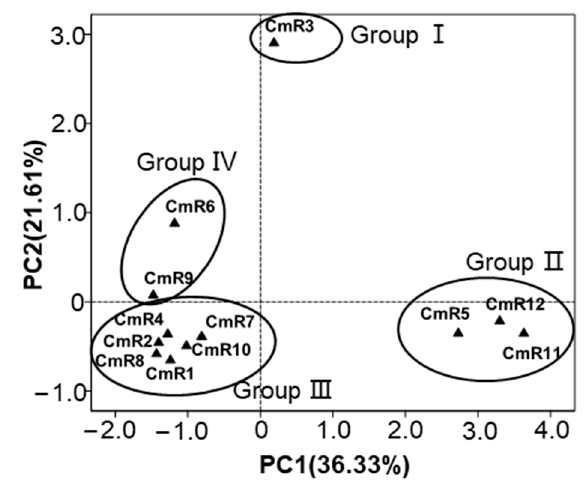
Figure 3. Principal component analysis (PCA) of the detected terpenoids of roots from 12 cultivars of C. morifolium. CmR1–12 refer to the cultivar codes in Table 1.